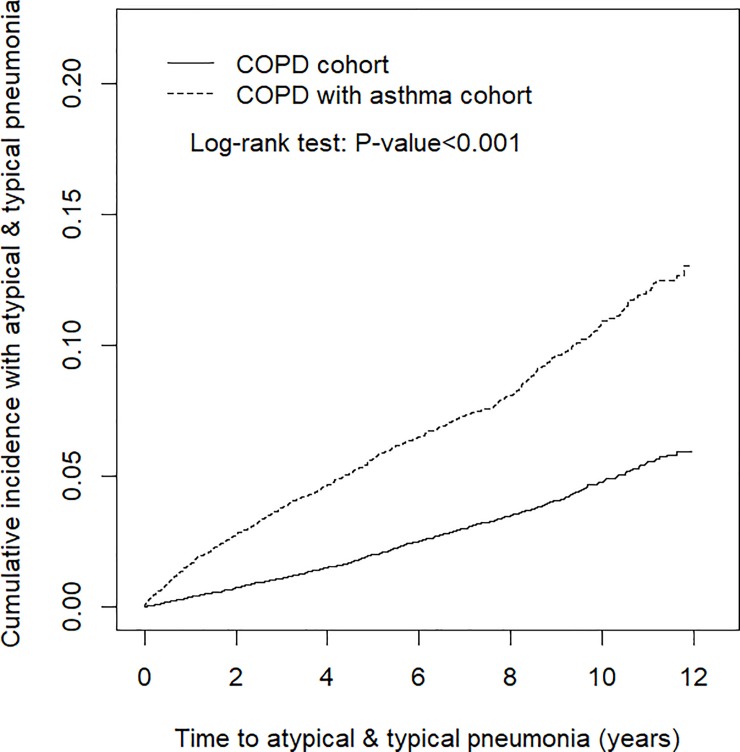
Cumulative incidence of atypical pneumonia and typical pneumonia in COPD with asthma cohort (dashed line) and COPD cohort (solid line). COPD, chronic obstructive pulmonary disease.